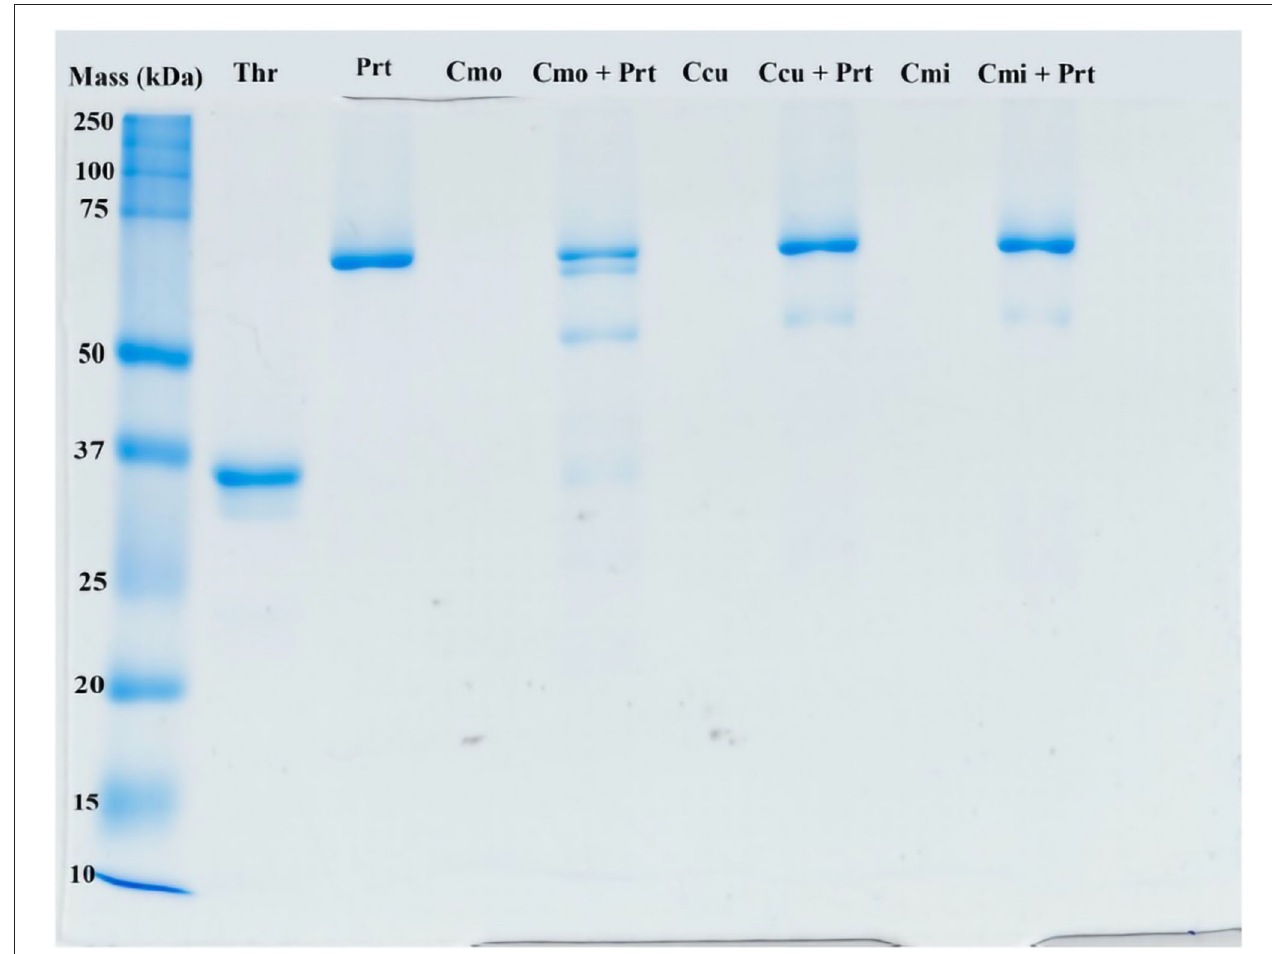
FIGURE 12 | Representative ID gel of selected rattlesnake venoms incubated with prothrombin to illustrate prothrombin products. The ladder on the far left shows molecular weights (kDA = kilodaltons). Thr, thrombin (positive control, i.e., typical final product of prothrombin cleavage); Prt, prothrombin; Cmo, C. m oaxacus ; Ccu, C. culminatus ; Cmi, C. mictlantecuhtli